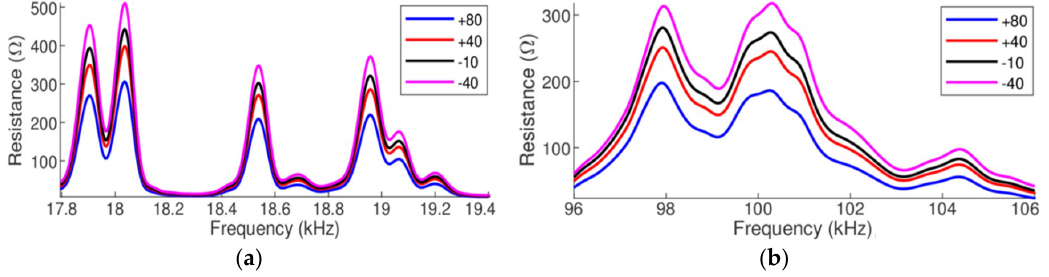
Figure 6. Vertical shift of the impedances (real part) pipe-1 / PZT-1: ( a ) at low frequency and ( b ) at high frequency.